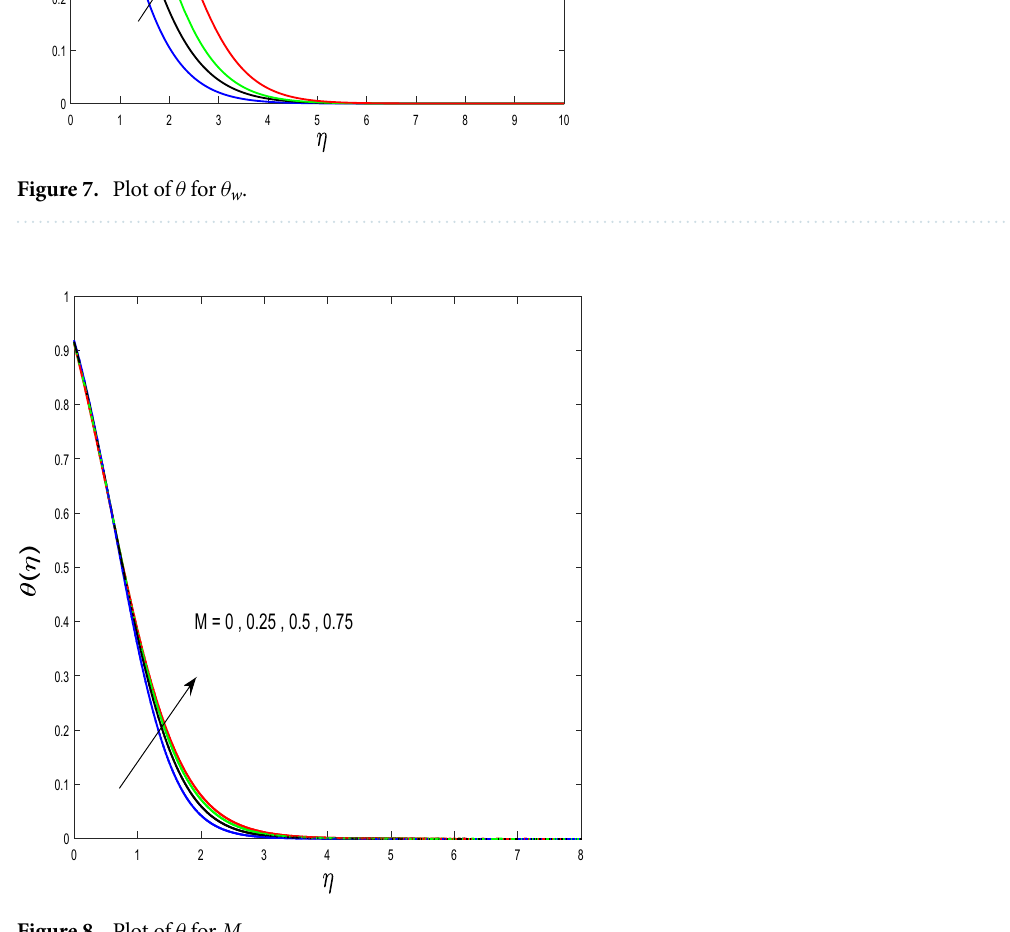
Figure 8. Plot of θ for M